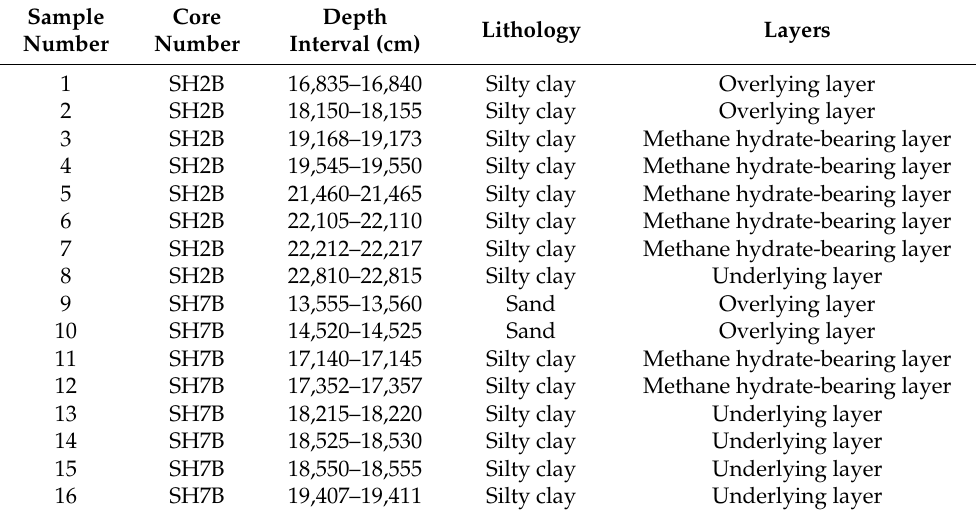
Figure 2. GC-MS chromatograms of the saturated hydrocarbon fractions from sediment core SH2B.The numbers above the main peaks indicate the carbon atom numbers of n -alkanes. Pr and Ph indicate pristane and phytane, respectively. Table 1. Sample information.